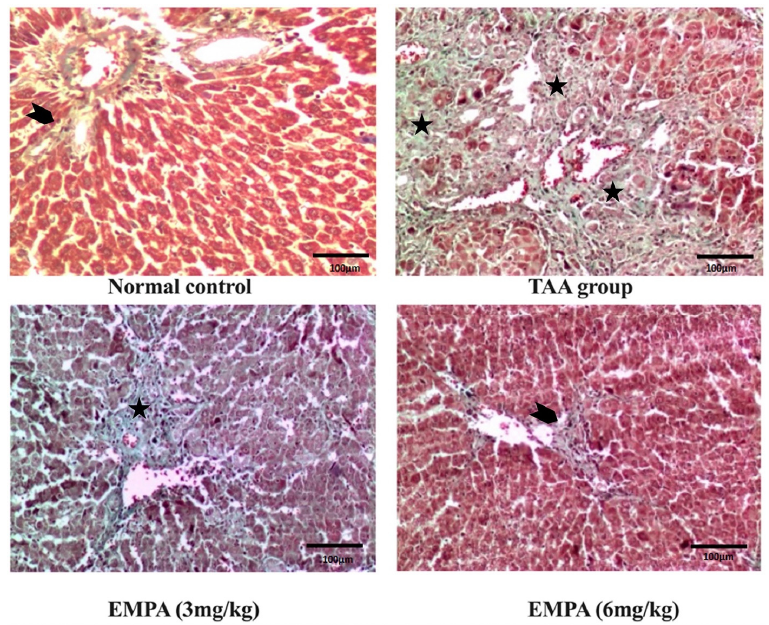
Figure 5. Photomicrographs of histopathology sections stained with Masson trichrome. The control group with only thin collagen in the wall of normal vascular structures (arrow head), disturbed architecture, and marked fibrosis in the toxic group (three asterisks), same findings as the toxic group in the 3 mg group (black asterisk), and regression of bands with minimal fibrosis (arrow head) in the group that received 6 mg. (magnification = 200 × ).